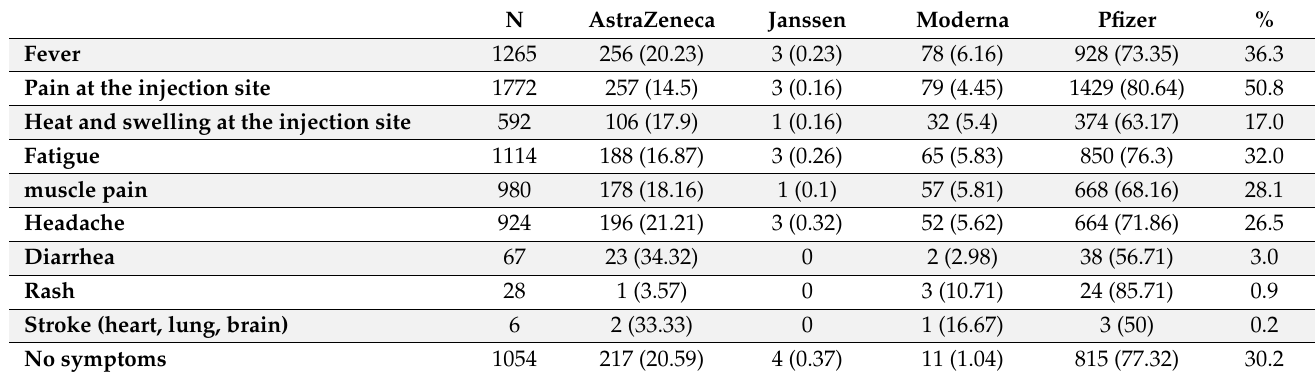
Table 3. Side effects after the second dose ( n =